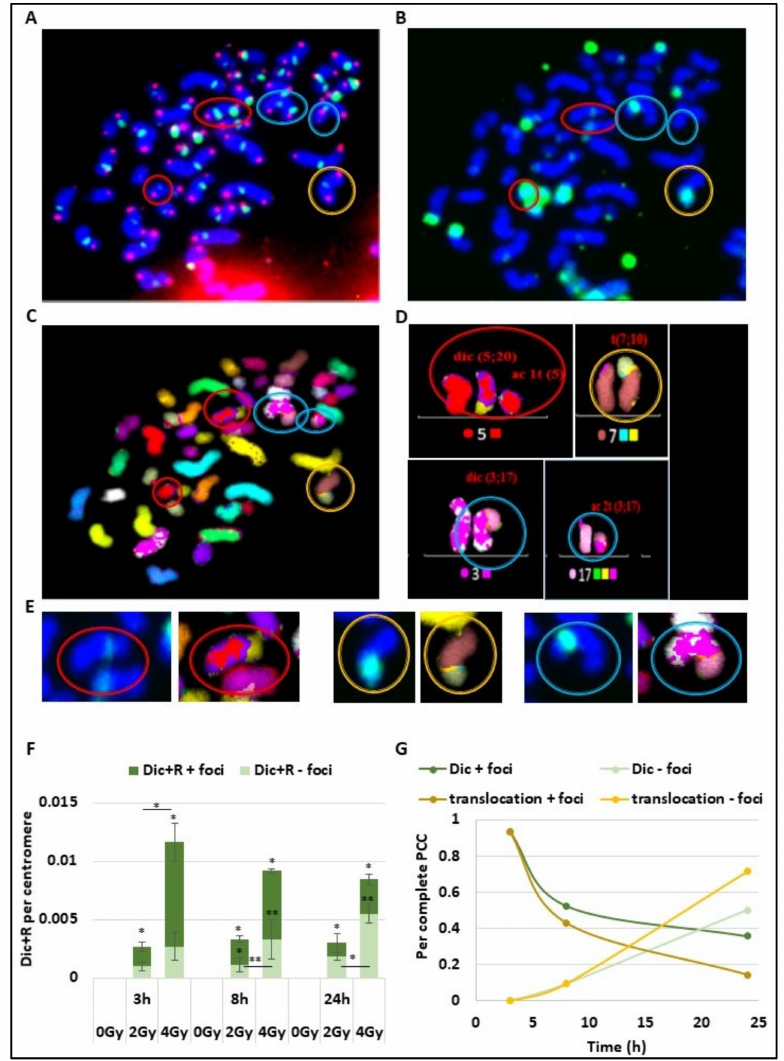
Figure 2. γ -H2AX foci signalling of unstable and stable aberrations short time after irradiation. ( A – D ) The same slide with PCC lymphocyte cells previously irradiated with 4 Gy was observed after telomere (in red) and centromere staining (in green) ( A ), γ -H2AX immunofluorescence assays have been performed with a FITC-coupled antibody (green) ( B ) or multi-FISH ( C ) and analysed with the ISIS software. Four abnormalities were detected and marked with coloured circles. The red and blue circles show dicentric chromosomes and their corresponding acentric fragments. The yellow circle shows a translocation between chromosomes 7 and 10. ( D ) Chromosome karyotype using false colours was built using the ISIS software. Data obtained from Telomere and Centromere staining and from multi-FISH were assembled to detect unstable and stable aberrations. ( E ) Zoom of CA stained for γ -H2AX (green) and visualized after multi-FISH. The foci localized at the junction between two chromosomes. ( F ) Blood samples from three donors were irradiated at 2 or 4 Gy or kept free from ionising radiation before analysis using the PCC technique. Dic + R frequency per centromere was scored 3 h, 6 h, and 24 h after IR and the percentage of co-staining with γ -H2AX foci was determined (dark green). The increase of “Dic + R + foci” or “Dic + R – foci” is significant (* p < 0.05, ** p < 0.001) at the di ff erent time points compared to 0 Gy. There is significant di ff erences when indicated between 2 Gy and 4 Gy irradiation (* p < 0.05, ** p < 0.001). ( G ) Only complete PCC cells (between 45 and 48 chromosome fragments) irradiated with 4Gy were analysed by multi-FISH after γ -H2AX foci immunofluorescence assay. Proportions of Dic + R and translocations signalled with γ -H2AX foci (in green part A) or without any γ -H2AX foci were represented over time. Respectively 15, 21, and 14 PCC were analysed for 0, 2, and 4 Gy